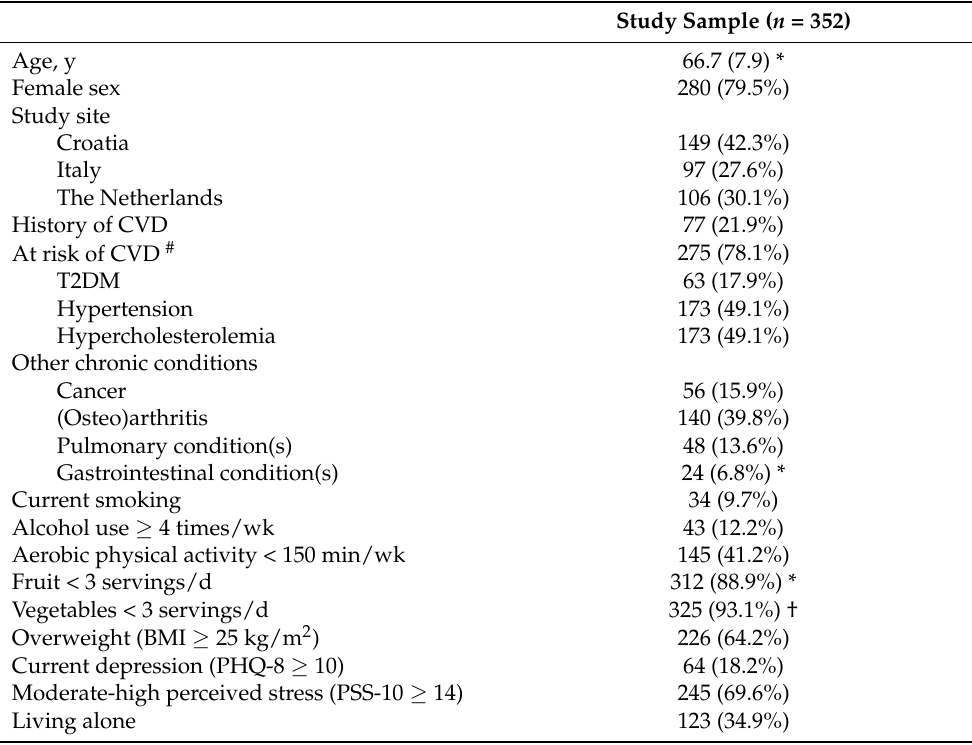
Table 1. Baseline characteristics of the SEFAC study sample ( n =